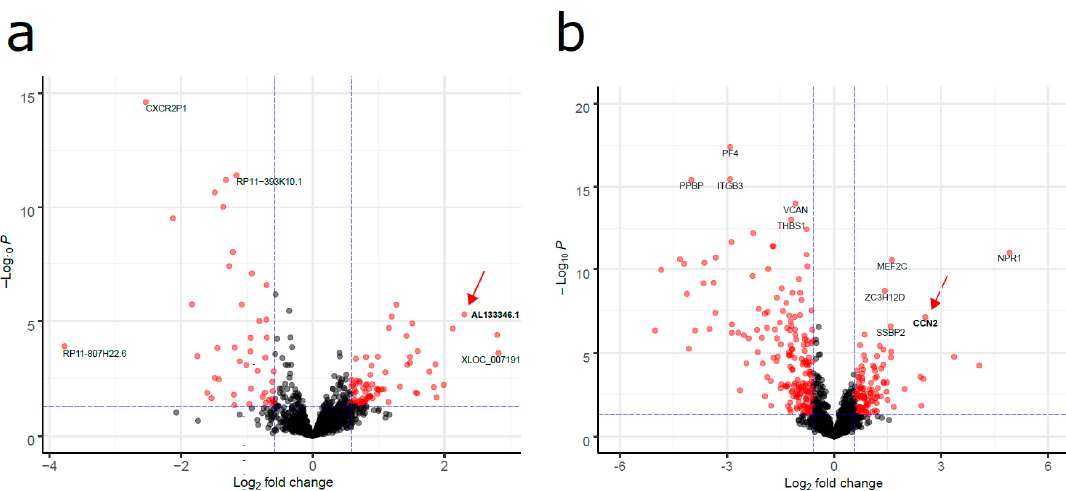
Figure 2. Volcano plot of the di ff erentially expressed lncRNAs ( a ) and protein-coding genes ( b ) in pediatric B-ALL vs. healthy bone marrows. The horizontal dashed line represents a threshold of FDR = 0.05. The vertical dashed lines represent the thresholds of fold change = − 1.5 and fold change = 1.5. Red dots represent the statistically significant di ff erentially expressed lncRNAs.